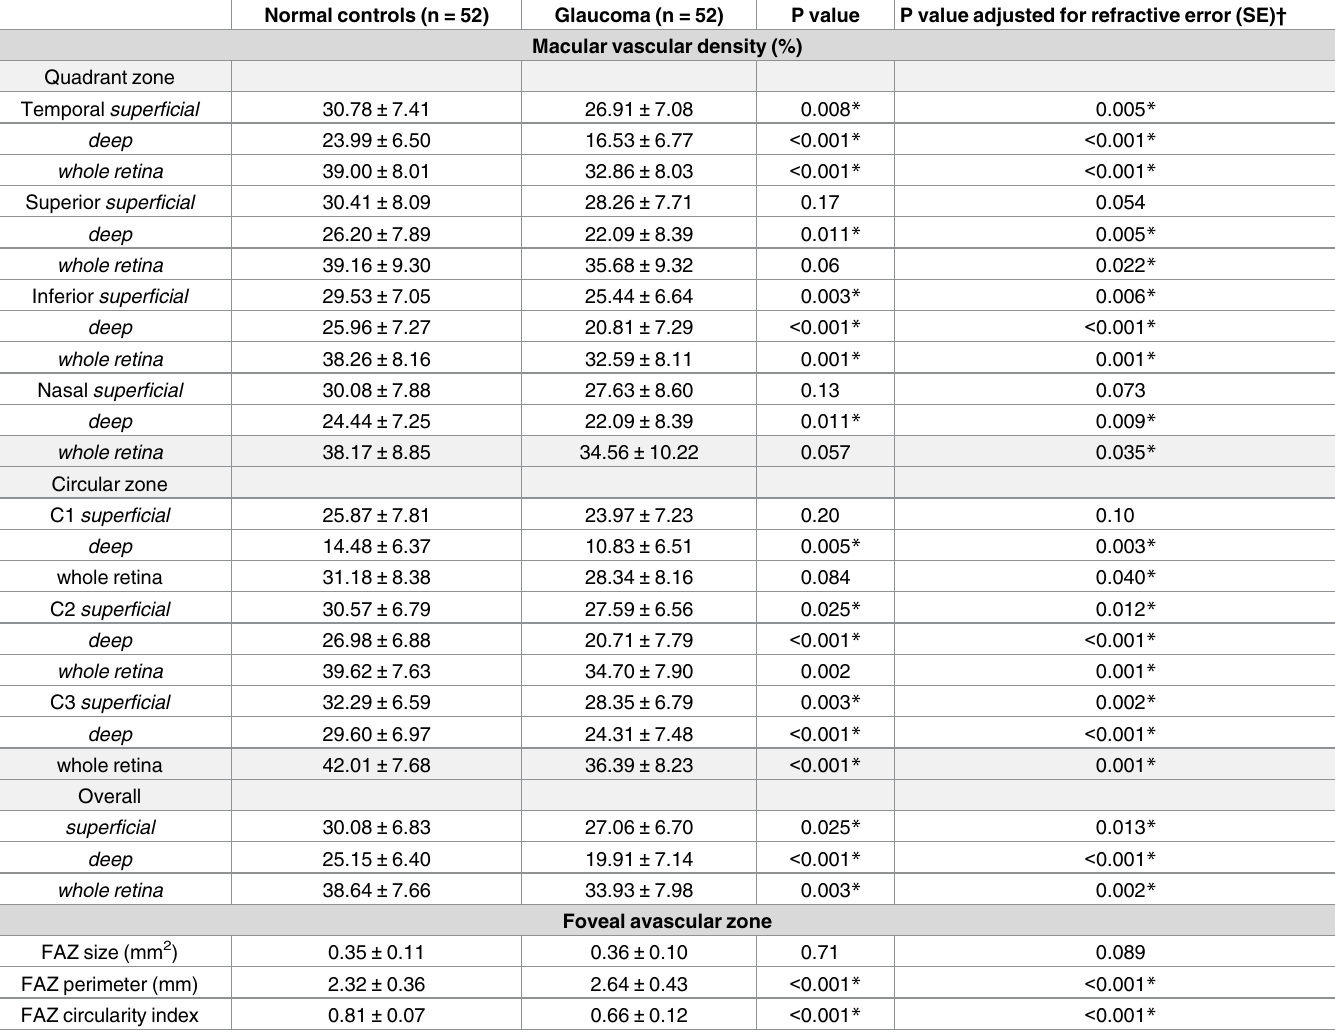
Table 2. Assessment of macular vasculardensity and foveal avascularzone by OCT angiography. Normal controls (n =